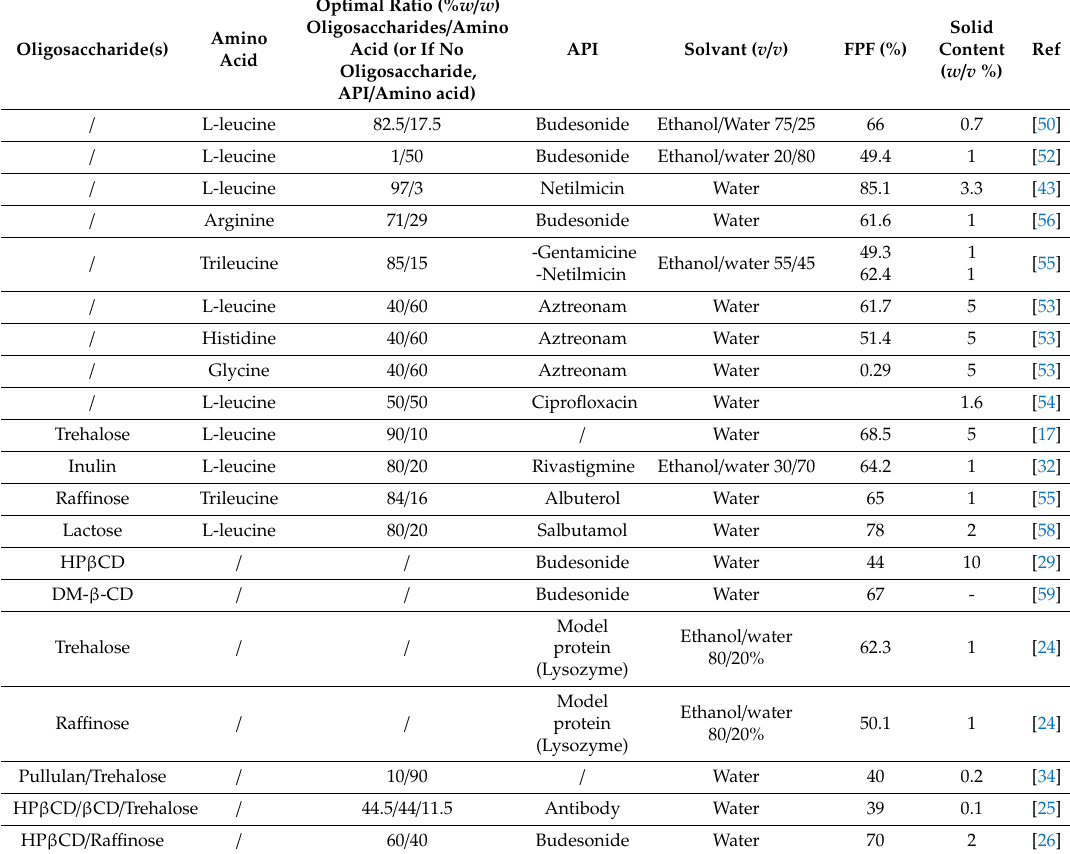
Table 2. Pharmaceutical powder engineering—oligosaccharide and amino acid combinations used to produce corrugated composite particles by spray drying and their relation to lung deposition e ffi cacy